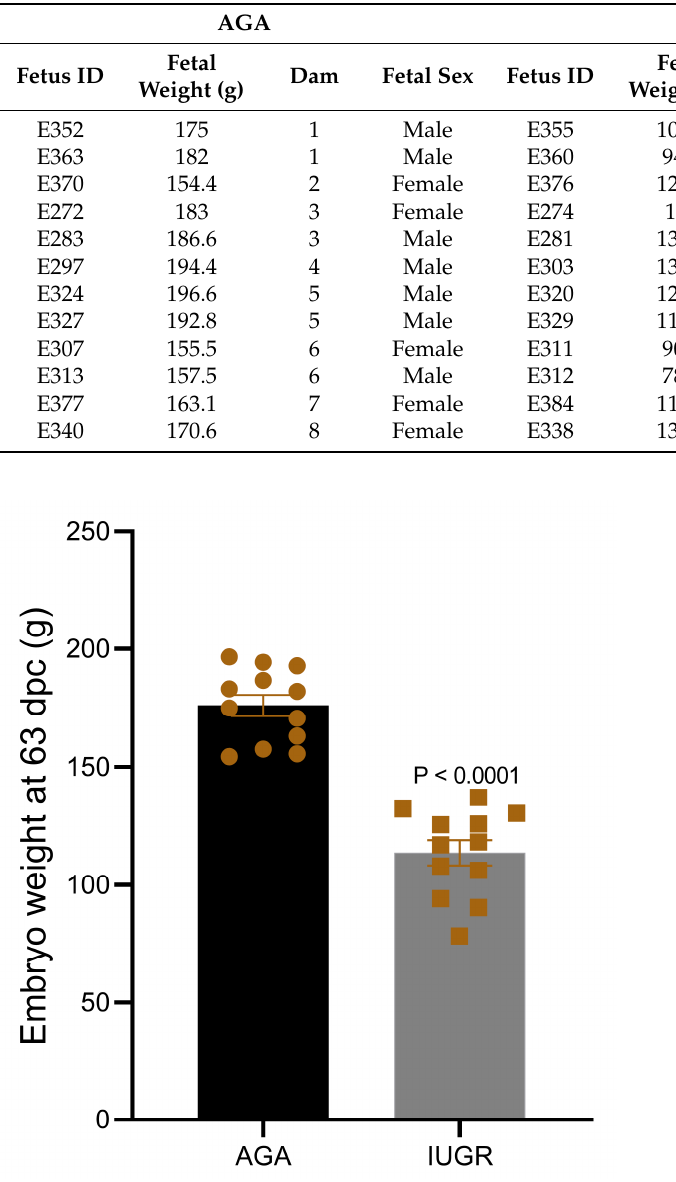
Figure 1. Weight of pig fetuses at 63 dpc in IUGR and AGA groups. The expression of 675 miRNA probe sets was measured to investigate their associa- tion with the body weight of pig fetuses at 63 dpc. A total of 47 miRNAs were significantly upregulated ( p < 0.05) and six miRNAs were significantly downregulated ( p < 0.05) in longissimus dorsi muscle (LDM) from IUGR fetuses compared to AGA fetuses (Figure 2). The top five significantly different miRNA between groups were miR-210, miR-30, miR-17- 3p, miR-199a, and miR-34a, which were all upregulated in IUGR fetuses. Moreover, out of 47,880 mRNA probe sets on the snowball microarray, 11,288 quality-filtered probe sets were further analyzed. A total of 477 genes were significantly downregulated (FDR < 0.05) and 3257 genes were significantly upregulated (FDR < 0.05) in LDM from IUGR fetuses compared to AGA fetuses (Figure